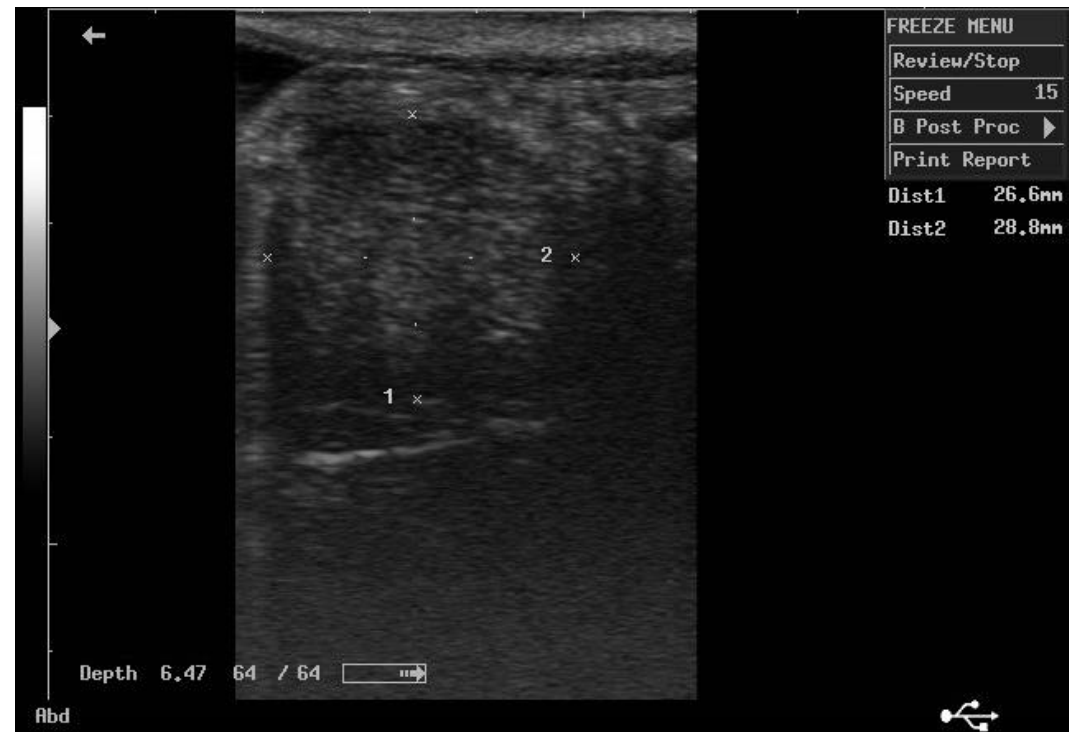
Figure 3. Ultrasound image of the middle tract of the post-pregnant uterine horn, at day 14 postpartum.